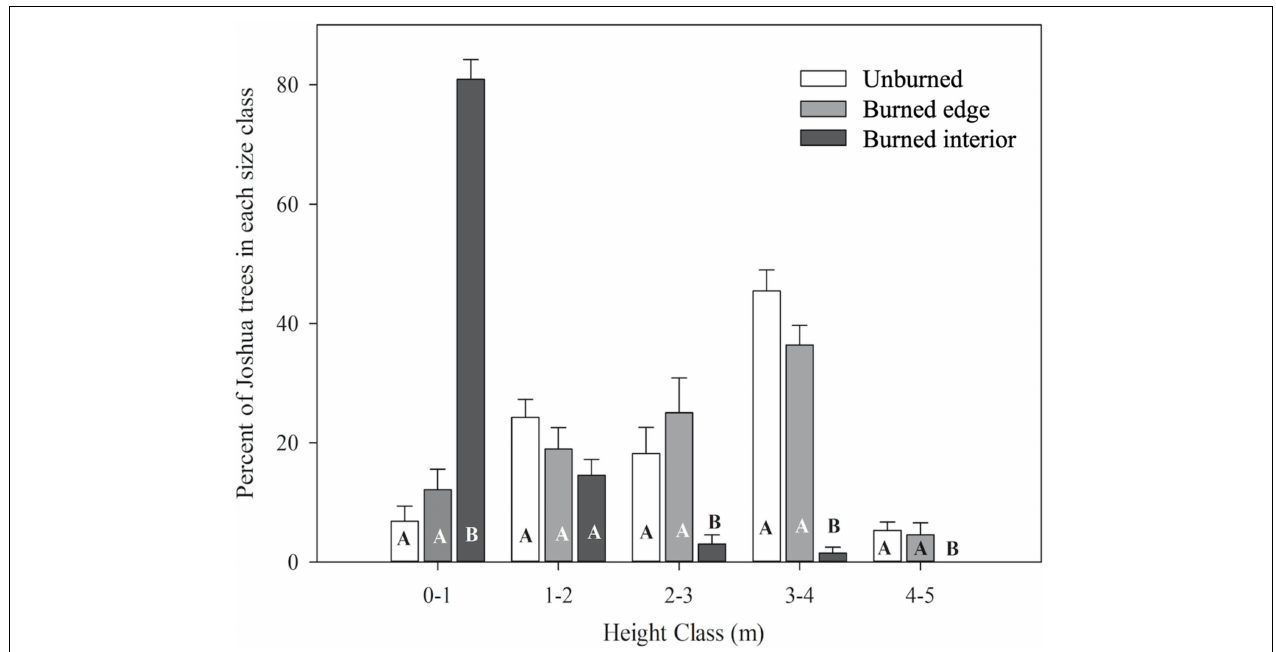
FIGURE 3 | Tree height distribution (means ± SE) of living Joshua trees along unburned, burned edge and burned interior transects. Different letters denote statistically significant difference in mean values ( P < 0.05) between different burn conditions within each height class using Tukey’s HSD. N = 6 for unburned and burned edges, N = 5 for burned